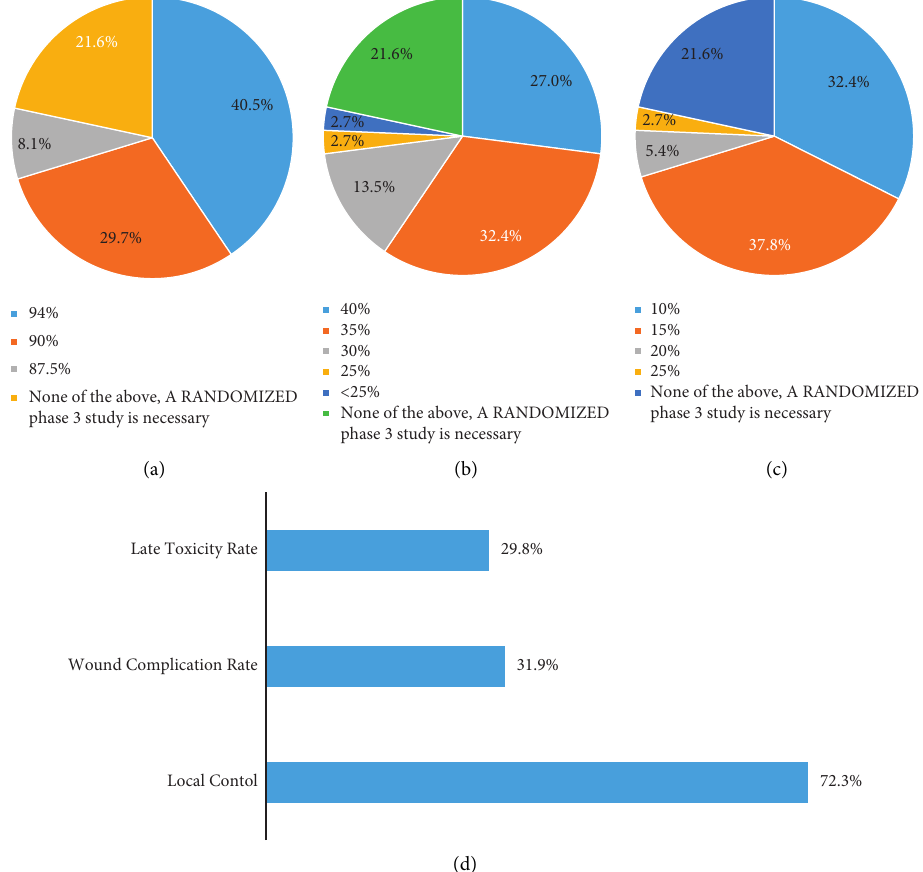
Figure 3: Optimal clinical trial endpoints and thresholds. Survey respondents ( n � 37) were asked to provide their (a) local control, (b) wound complication, and (c) late toxicity thresholds for incorporating 5-day preoperative RTas a standard-of-care option. (d) Respondents ( n � 47) prioritized the most important among these three endpoints. Free-form responses are not included in the color-coded